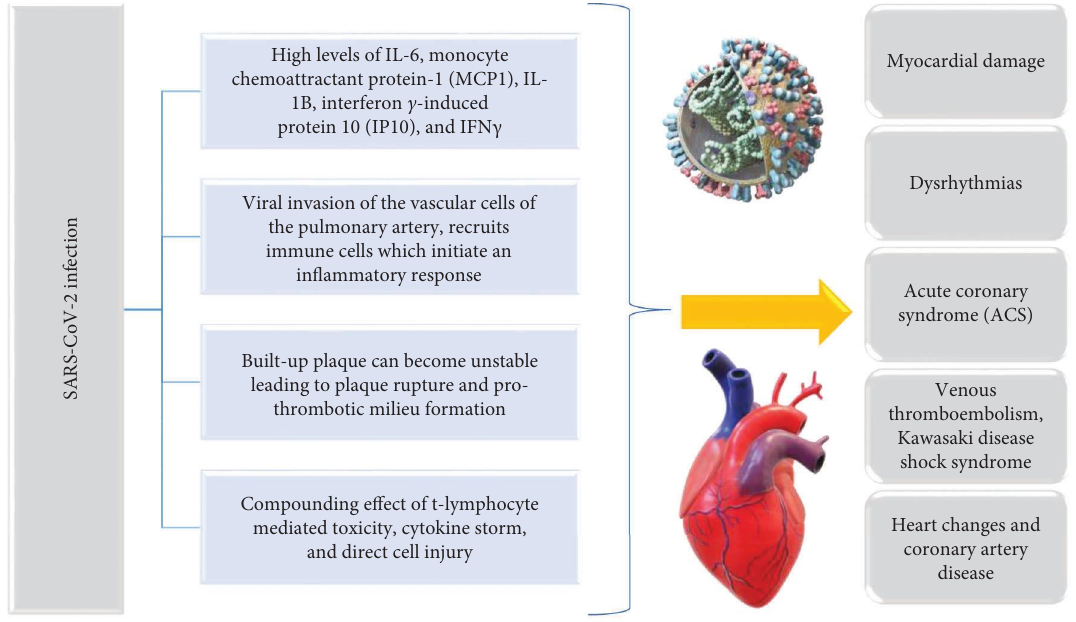
Figure 3: Main characteristics/changes induced by the viral infection in cardiac